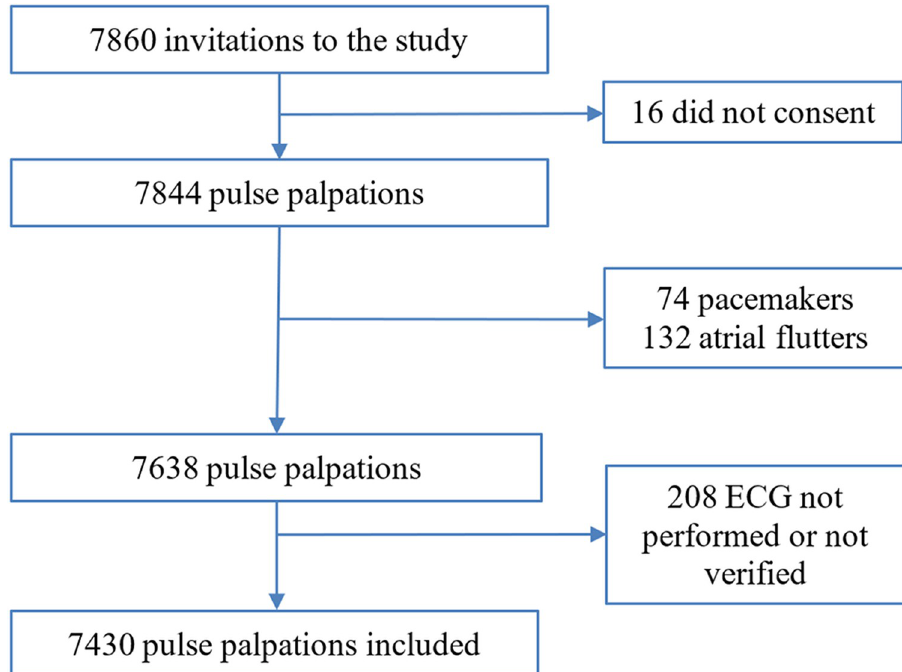
Fig 1. Study flow